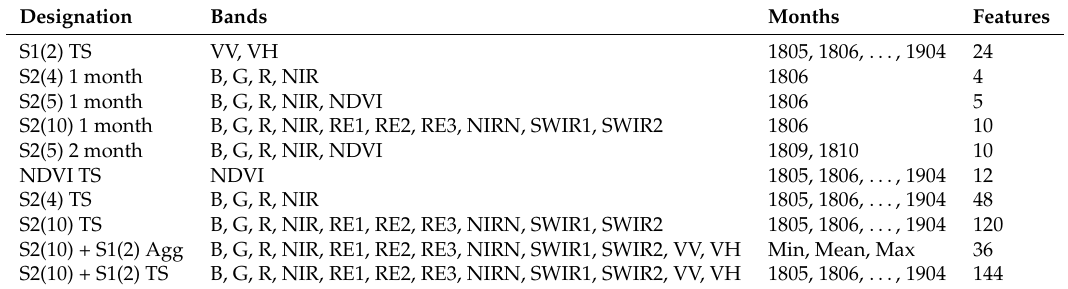
Table 3. Band combinations used in supervised classification. TS = time series. Agg = aggregate bands computed per pixel over the twelve months. Months are indicated as YYMM (e.g., 1805 is May